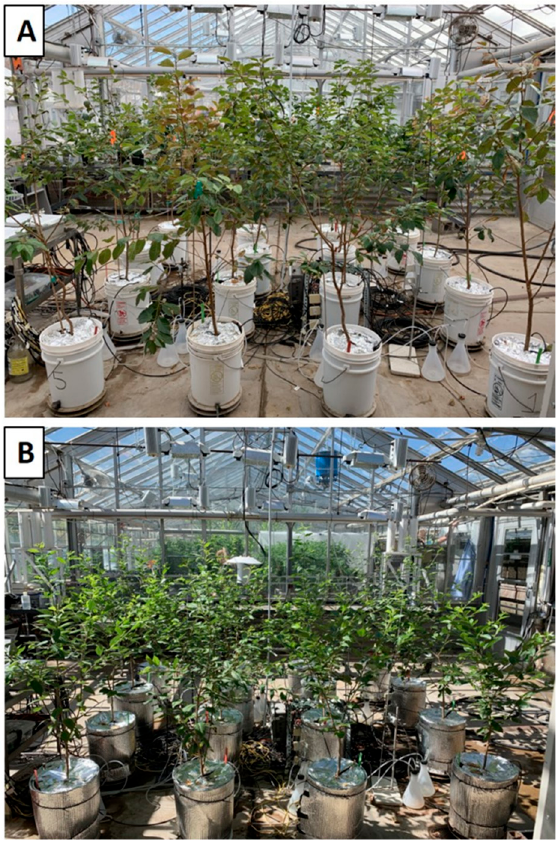
Figure 1. The 16-cell lysimeter system used to assess transpiration rates for Krymsk ® 5 and 6 rootstocks for Trial 1 ( A ) and Trial 2 ( B ). Containers were covered with aluminum foil to minimize evaporation from the soil surface. Three drought cycles were imposed during each trial period.